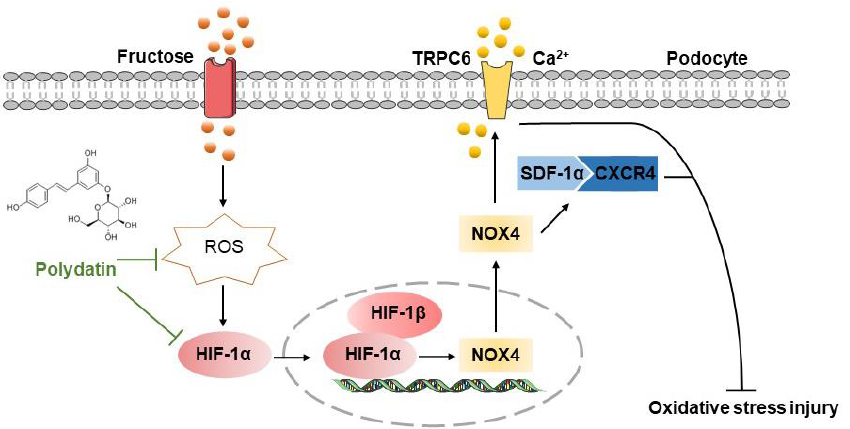
Figure 7. The hypothetical mechanism by which polydatin ameliorates high fructose-induced glomerular podocyte oxidative stress damage. Polydatin protected against high fructose-induced glomerular podocyte oxidative stress. It decreased ROS to down-regulate HIF-1 α and NOX4 and then inhibited the activation of the SDF-1 α /CXCR4 axis to up-regulate nephrin and podocin and down-regulate TRPC6, resulting in the improvement of podocyte injury.